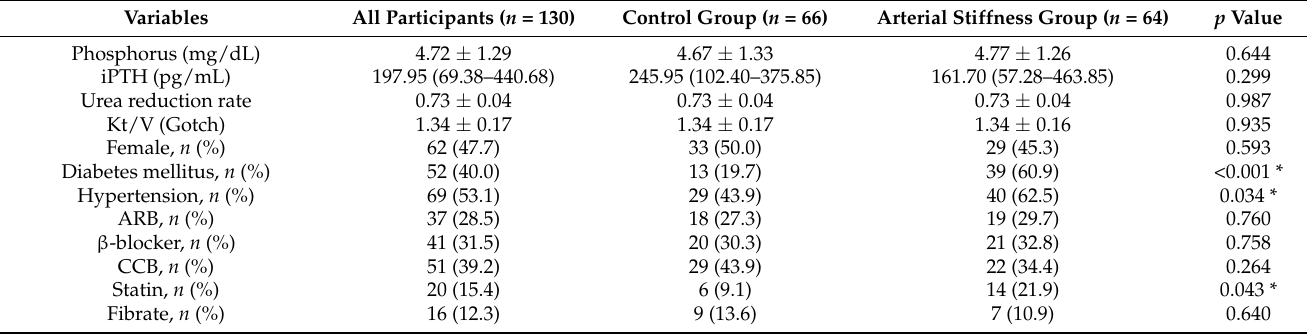
Table 3. Hazard ratio for all-cause mortality events by multivariable Cox regression of carotid-fem- oral pulse wave velocity levels among the 130 hemodialysis patients.